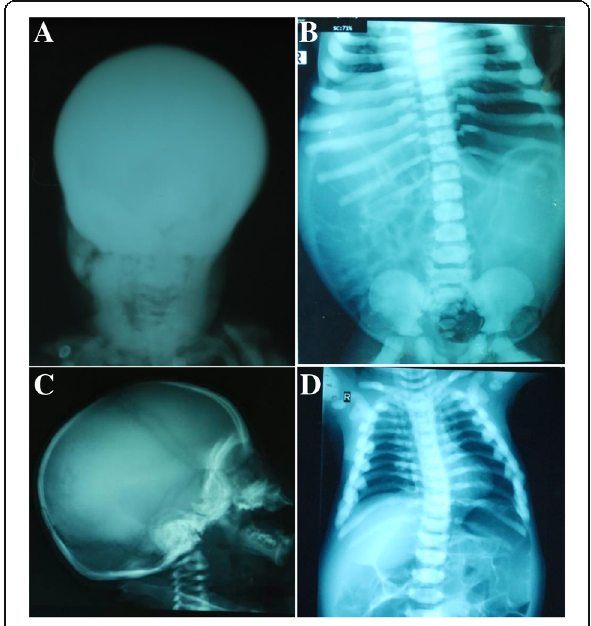
Fig. 2 Radiological investigations. a Individual IV: 1; image shows diffusely thickened and sclerotic skull with increased density of visualized bones b Prominent diffuse increase in bone density in ribs, visualized dorosolumber spine and pelvic bones as well as widening of costochondral junctions. c Individual IV: 3, image shows diffuse dense calvarium with increased density of rest of the visualized bones d Generalized diffuse increase in bone density, mild scoliosis of dorsal spine with convexity towards left side and loss of corticomedullary